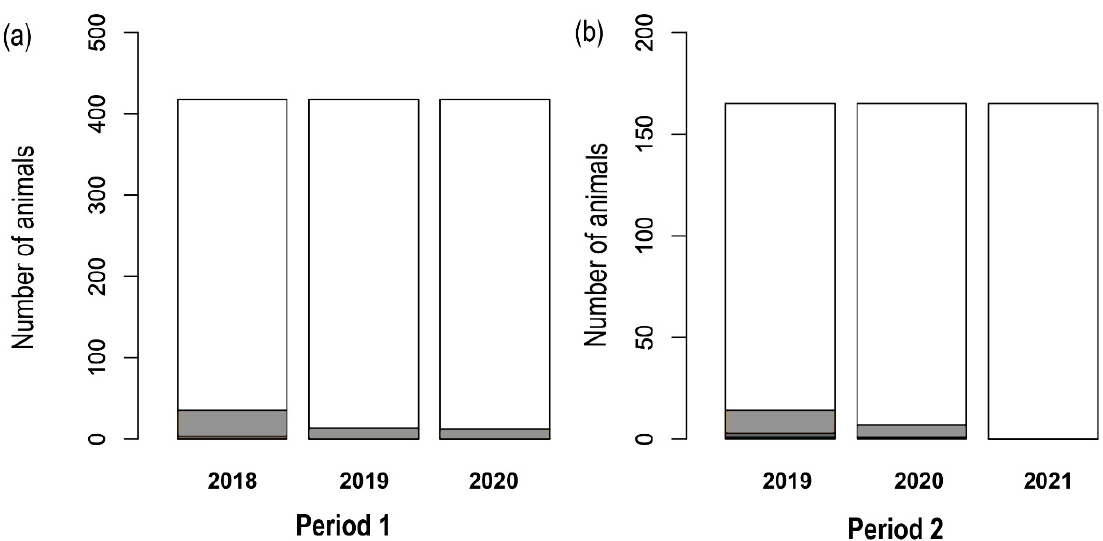
Figure 1. Distribution of adverse reactions during the first ( a ) and the second ( b ) study period. Severity of the reactions is reported in different colors (black: severe; dark gray: moderate; light gray: mild; white: no reaction).